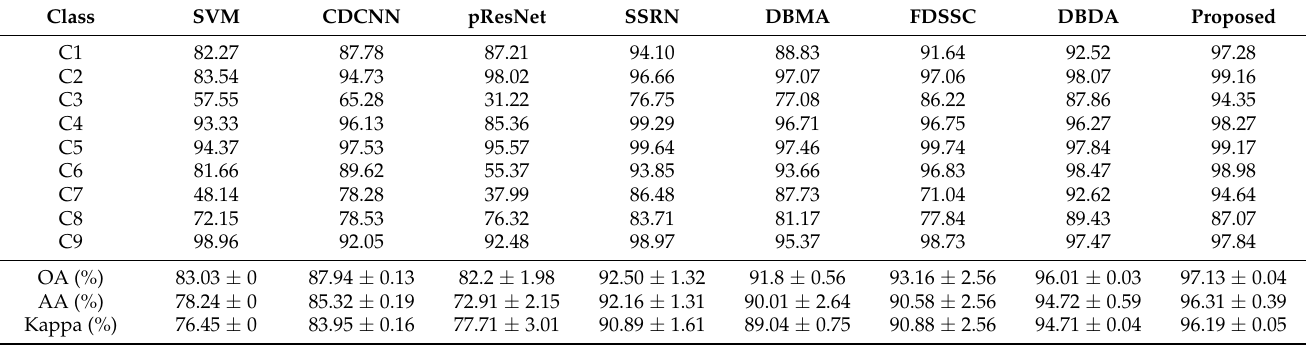
Table 7. KPI (OA, AA, Kappa) on Pavia University (UP) data set with 0.5% training